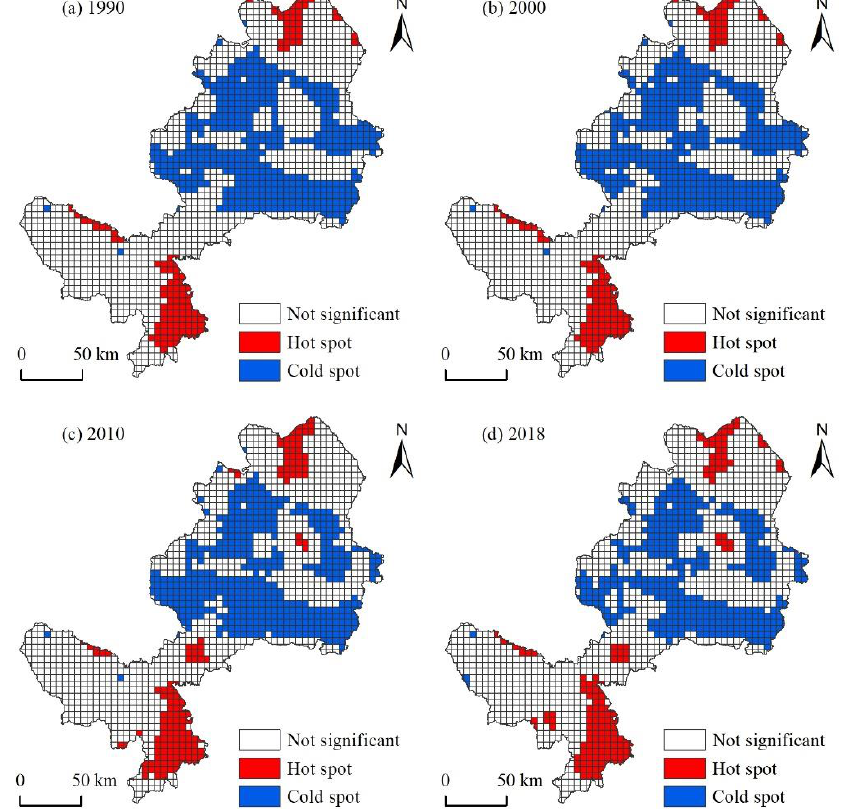
Figure 6. Analysis on Cold and Hot Spots of Landscape Ecological Risks in EFZUYR. ( a ) 1990; ( b ) 2000; ( c ) 2010 and ( d ) 2018.